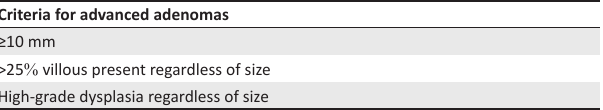
TABLE 6: Advanced adenomas † .